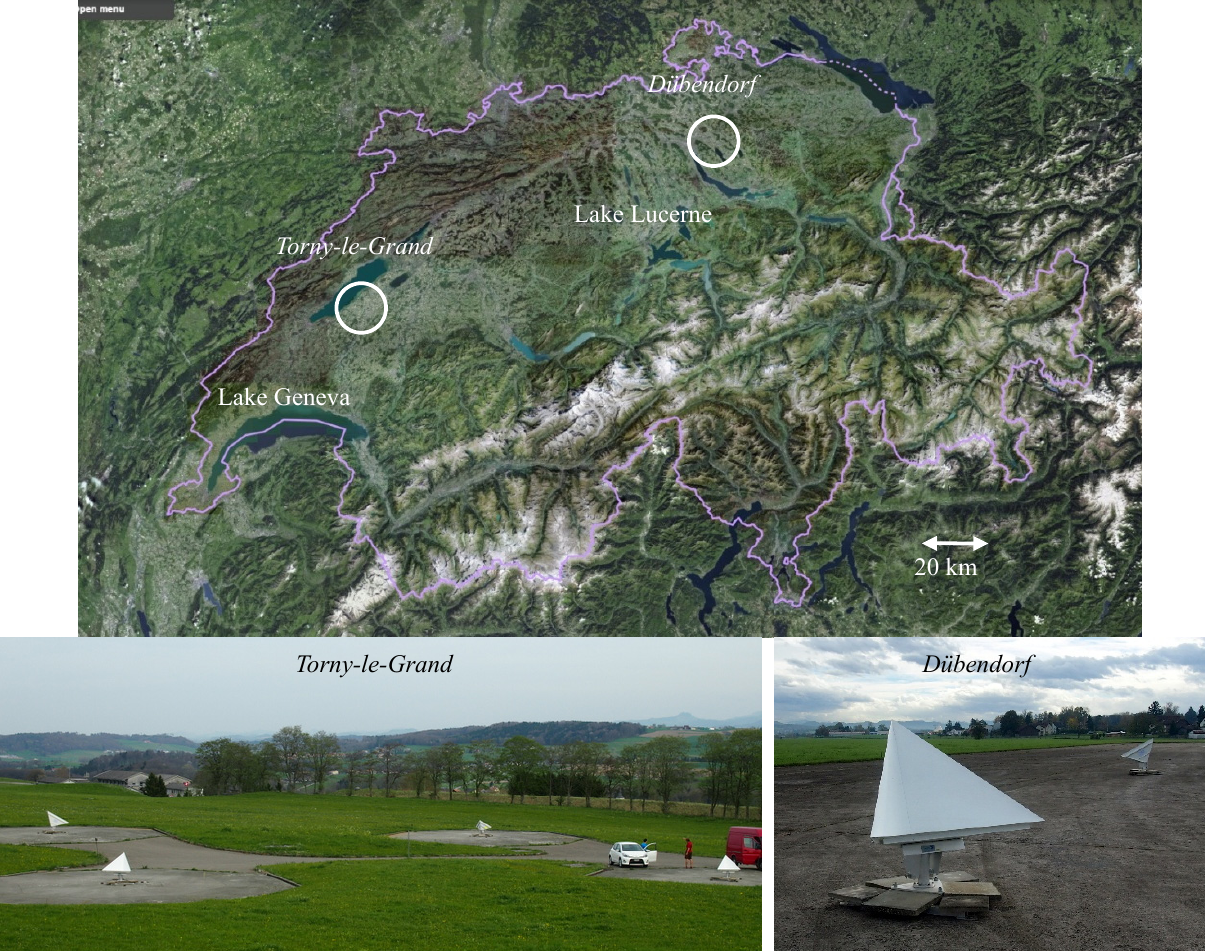
Figure 1. University of Zurich (Switzerland) corner reflector test sites Torny-le-Grand and Dübendorf . Four reflectors (two per orbital direction) were located at Torny-le-Grand from April to October 2014, then two (one per orbital direction) at Dübendorf from October 2014 to January